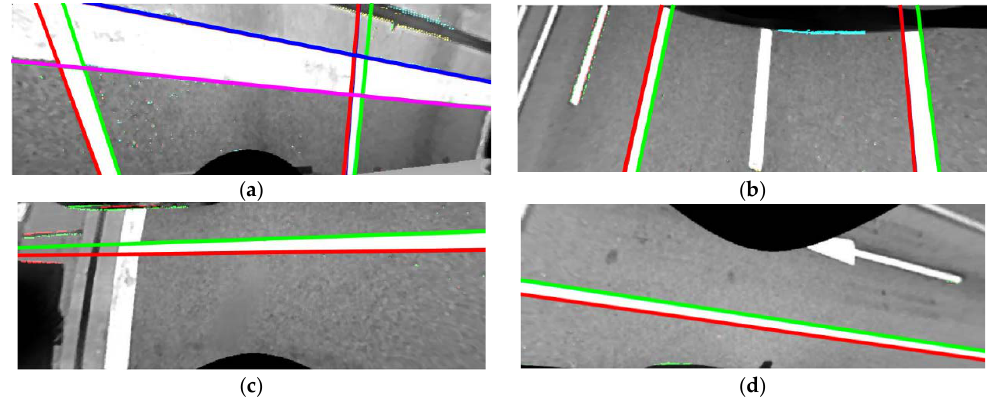
Figure 6. Example detection results of lane marking and stop line. ( a ) Two lanes and a stop line detected in a front camera image; ( b ) Two lanes detected in a rear camera image; ( c ) A left lane detected in a left camera image; ( d ) A right lane detected in a right camera image.